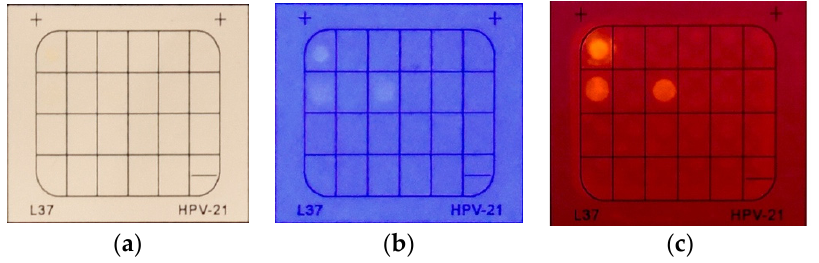
Figure 5. Photography of the HybriMem stained with HCAP in the standard condition of protocol, showing ( a ) daylight, ( b ) 395 nm LED flashlight, and ( c ) 395 nm LED flashlight with optical bandpass filter (600–700 nm). [HCAP] = 0.1 mM; probe incubation time: 5 min; PCR cycle: 40.